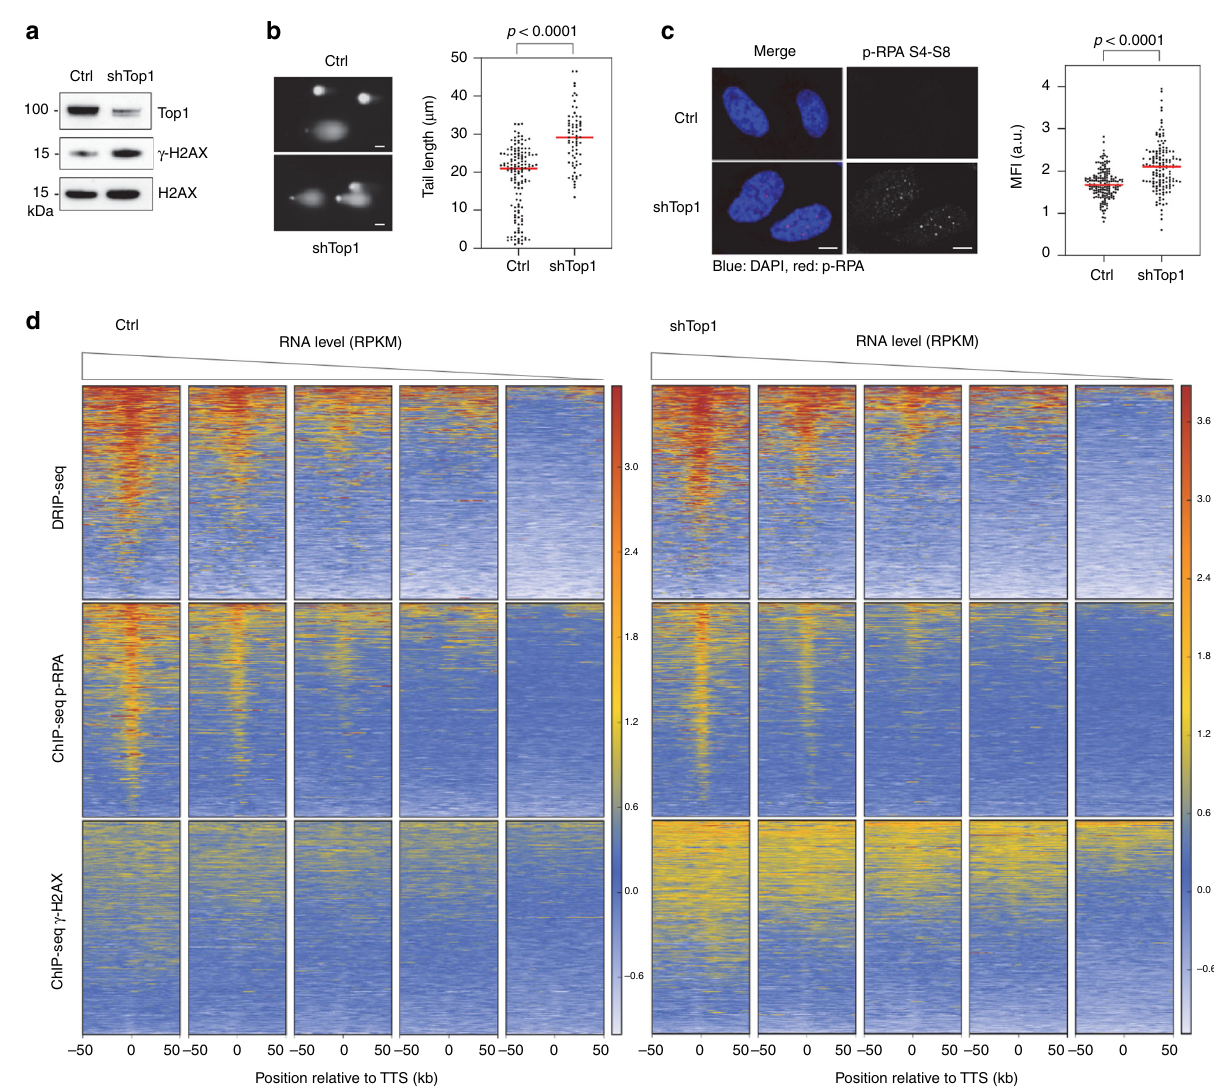
Fig. 3 Top1 prevents the accumulation of γ -H2AX at highly expressed genes. a Western blot analysis of γ -H2AX levels in control and shTop1 cells ( n = 3). b Analysis of DNA breaks in control and shTop1 cells. Representative images and the distribution of comet tail lengths are shown. Median of tail length is indicated in red. At least 50 cells of each sample were measured ( n = 2). Bar is 10 µ m. P -values were calculated with the two-sided Mann – Whitney rank- sum test. c Immunodetection of phospho-RPA32 S4/S8 in control and shTop1 cells. Mean fl uorescence intensity (MFI) of the p-RPA32 S4/S8 signals is indicated in red. At least 400 cells of each sample were quanti fi ed ( n = 3). P -values were calculated with the two-sided Mann – Whitney rank-sum test. Bar is 5 μ m. d Heat map of the intensity of RNA:DNA hybrids (DRIP), p-RPA and γ -H2AX at TTS in control and shTop1 HeLa cells for fi ve groups of genes with decreasing expression levels (RNA-seq). In each group, genes were sorted relative to the intensity of DRIP γ -H2AX levels (Fig. 4f, h, i), unlike shTop1 cells (Fig. 3d). Altogether, these data indicate that DSBs form more frequently in shTop1 cells than in shSRSF1 and control cells and suggest that